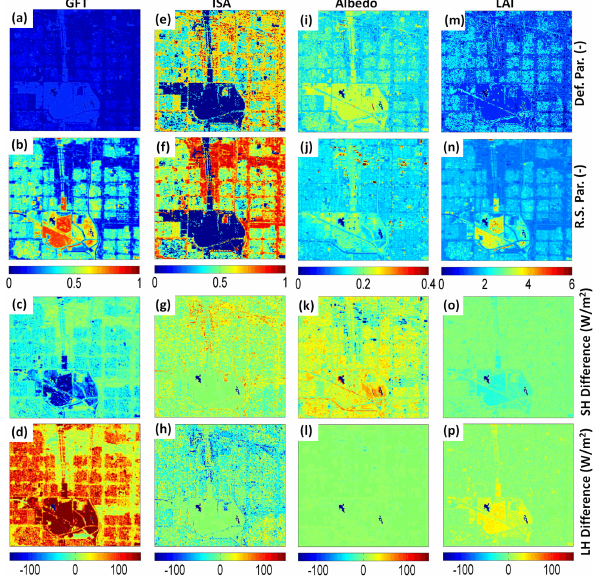
Figure 3. Spatial distributions of GVF, ISA, albedo, and LAI based on Noah-UCM lookup tables (row 1) compared with remotely sensed values (row 2) and simulated difference maps of sensi- ble (row 3) and latent (row 4) heat fluxes using default and re- motely sensed urban surface parameters: ( c and d ) GVF, ( g and h ) ISA, ( k and l ) albedo, and ( o and p ) LAI. Valid at 11:00LST on 14 April